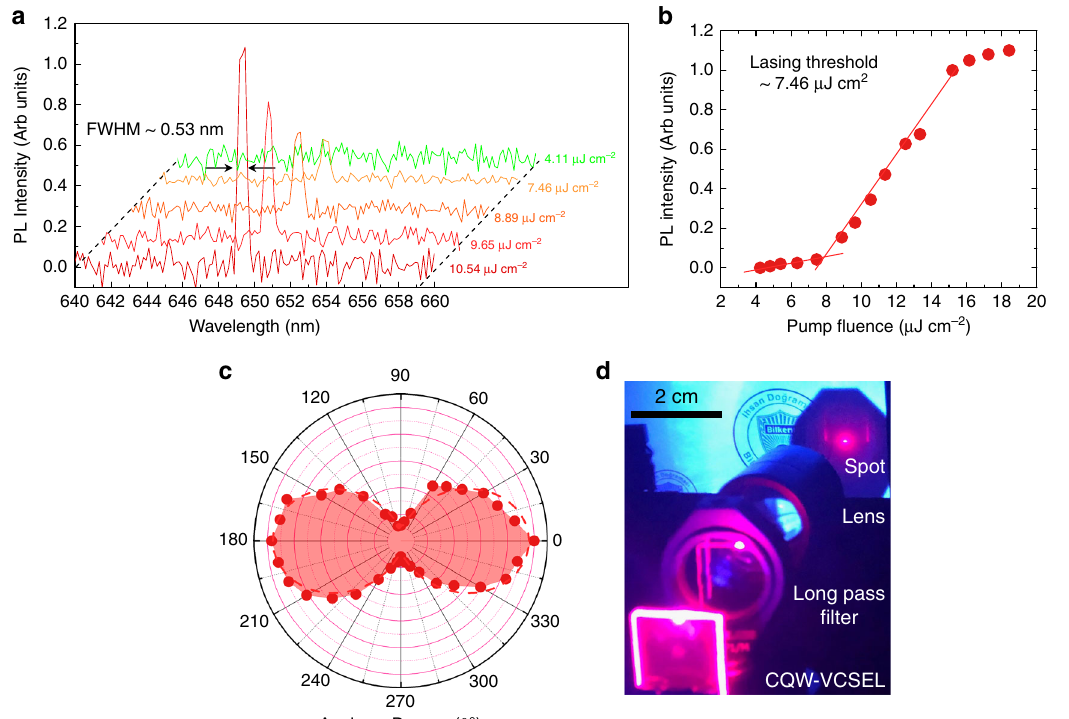
Fig. 4 Lasing characterization of CQW – VCSEL. a PL spectra of CQWs-VCSEL as a function of the pump fl uence. From the linewidth of the laser emission, the quality factor (Q) is calculated as ~1200. b Emission intensity versus pump intensity (symbols). The red solid line indicating the lasing threshold of ~7.46 μ J cm − 2 . c Normalized emission spectrum of CQWs-VCSEL above the lasing threshold (~12 μ J cm − 2 ) as a function of the polarizer angle ( θ ) and the detector at the front of the cavity. The dashed red line is the fi tting of cos 2 ( θ ) curve. d Photographical image of the CQWs-VCSEL above the lasing threshold indicating a well-de fi ned spatial lasing spot on the